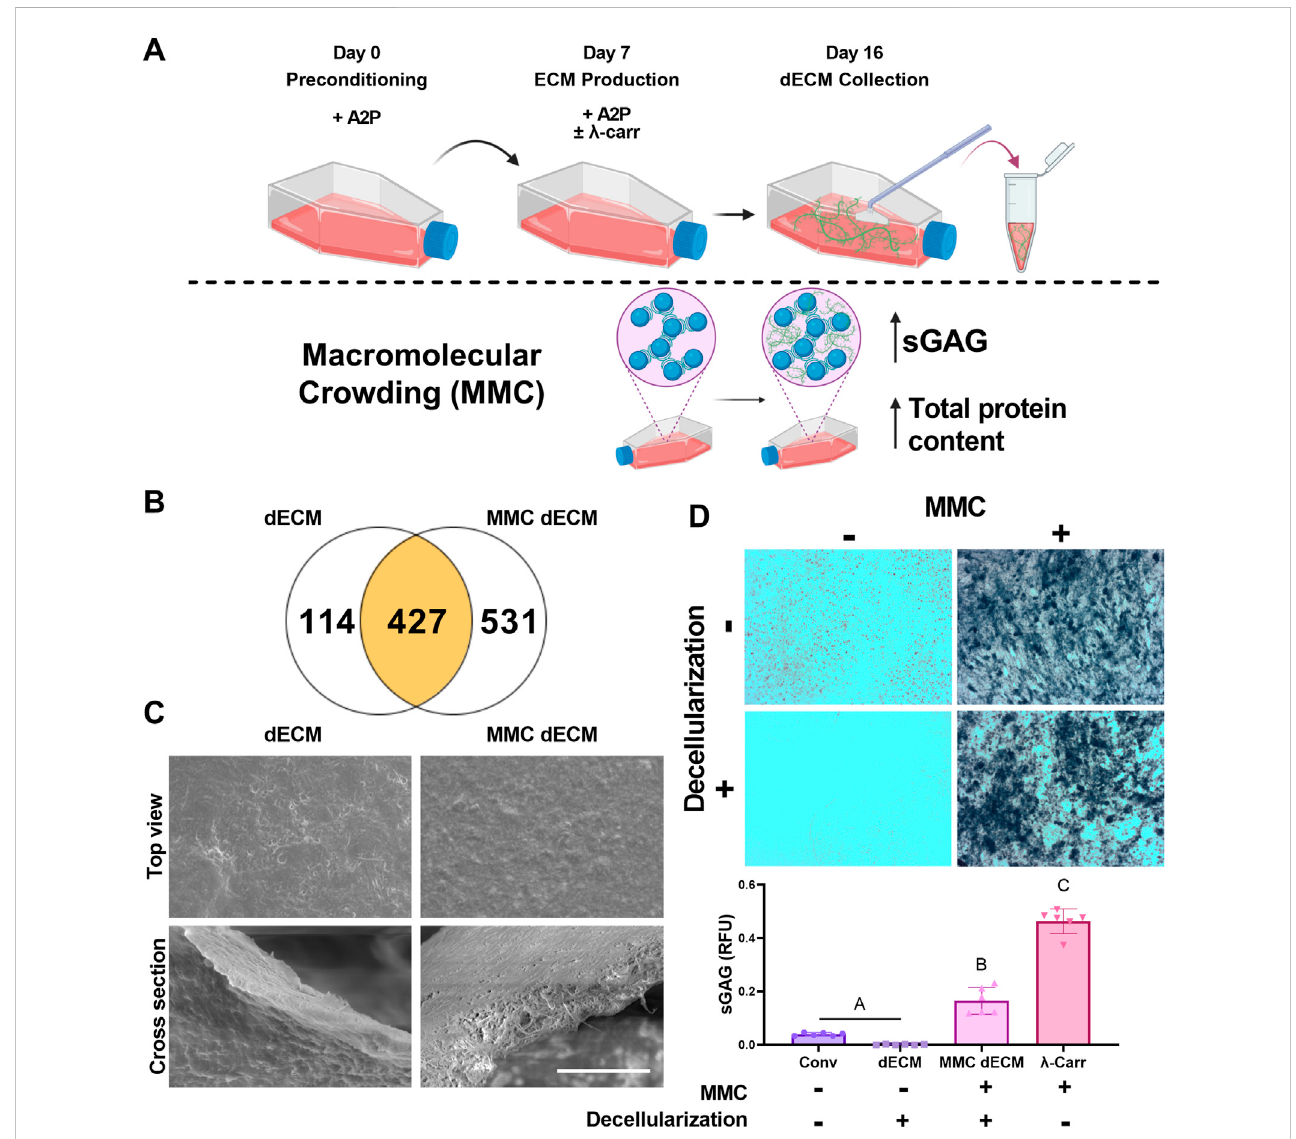
FIGURE 1 Macromolecular crowding increases sulfated glycosaminoglycan content within a cell-secreted extracellular matrix (ECM). (A) Schematic of ECM culture. (B) Mass spectrometry revealed the number of unique proteins within λ -carrageenan ECM (MMC dECM) compared to ECM produced without λ -carrageenan (dECM). (C) Topographical representation of ECM imaged via scanning electron microscopy. Scale bar is 5 μ m (×20,000 magni fi cation) (D) Alcian blue staining identi fi ed the presence of sulfated glycosaminoglycans (sGAG) in culture (top) and upon quanti fi cation of staining (bottom). MMC dECM was decellularized with DNase, while dECM was decellularized with Triton X-100 and DNase. Data are mean ± std., deviation ( n = 6). Groups with different letters are signi fi cantly different determined by one-way